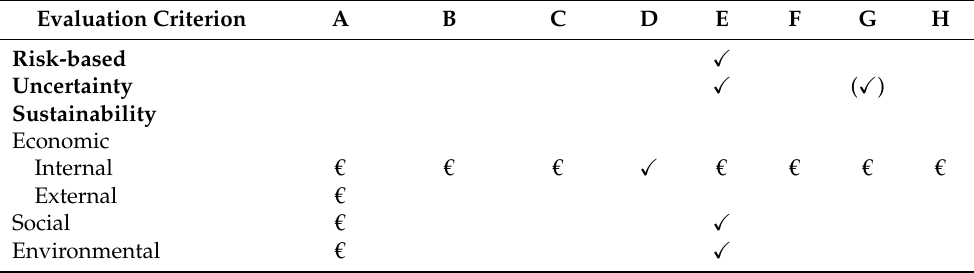
Table 4. Evaluation of models based on framework. A: Sola et al. [29], B: Davalos et al. [30], C: Diogo et al. [31], D: Moskwa et al. [32], E: Vallin [33], F: Lee et al. [34], G: King County [35], H: DeMonsabert and Thornton